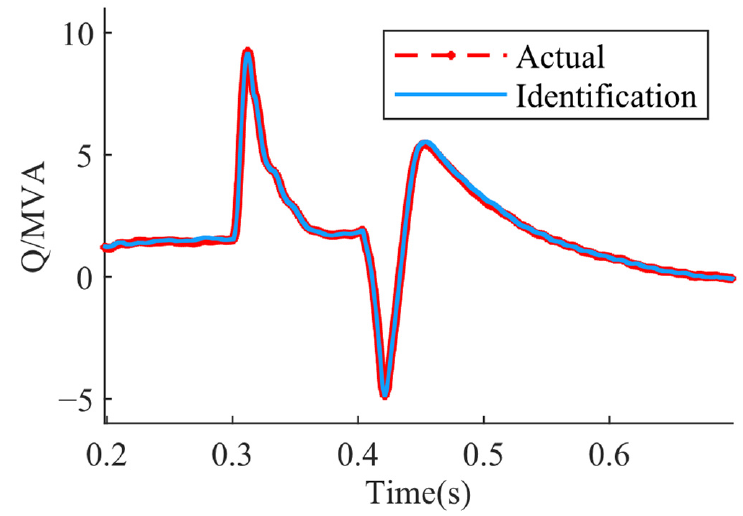
Figure 20. The reactive power output of the actual model and the discriminated model.